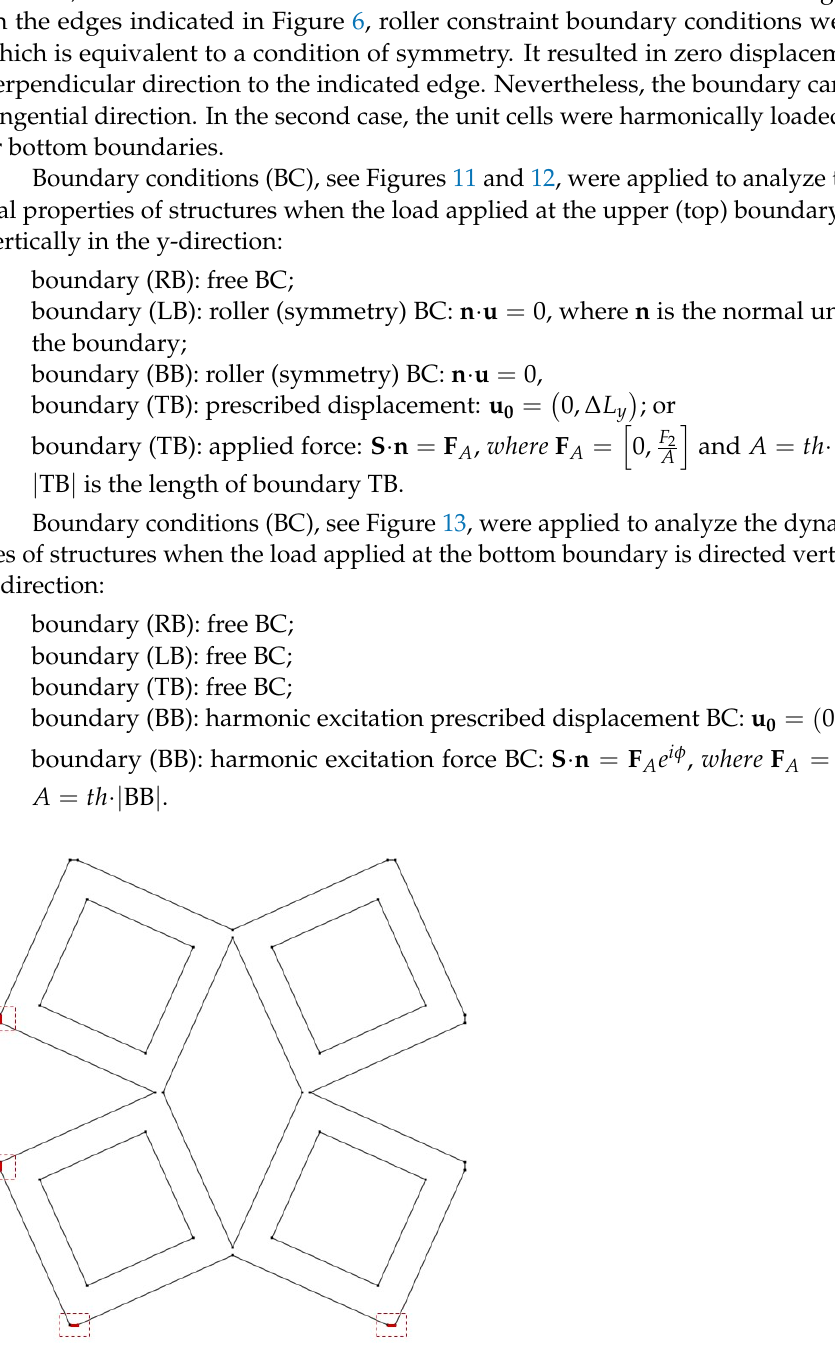
Figure 11. The edges constraint using roller boundary condition.